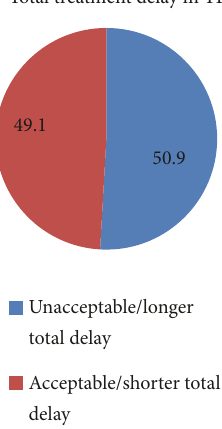
Figure 1: Total treatment delay in